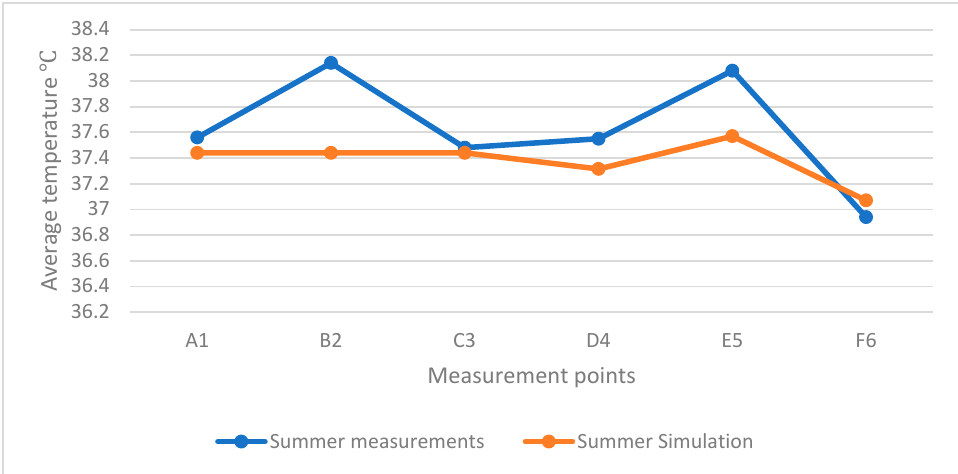
Figure 6. Comparison of the measured and simulated summer wind environment in Zhuqiao village.